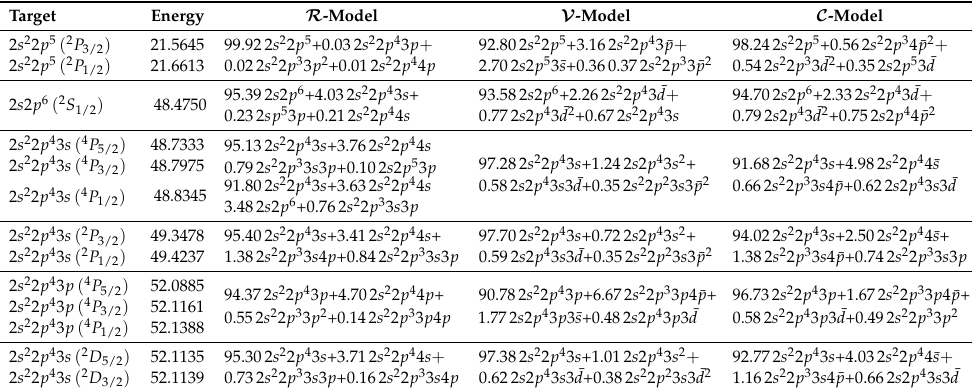
Table 1. Target states (named by the leading term in LSJ approximation), the leading terms in configuration mixing (in percent) and energies according to NIST database [65]. Core 1 s 2 is omitted for